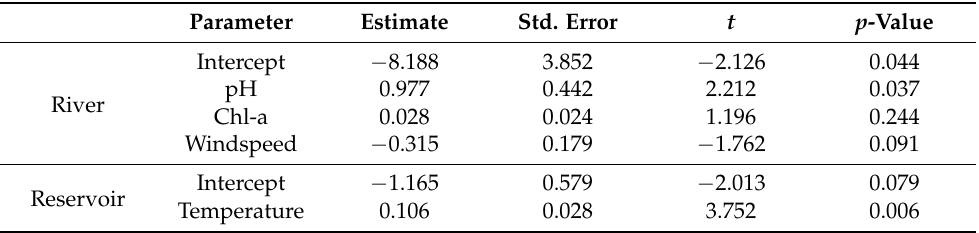
Table 2. Parameter estimates for the best model developed for explaining the total FCH 4 in the rivers (R 2 = 0.40) and reservoirs (R 2 =